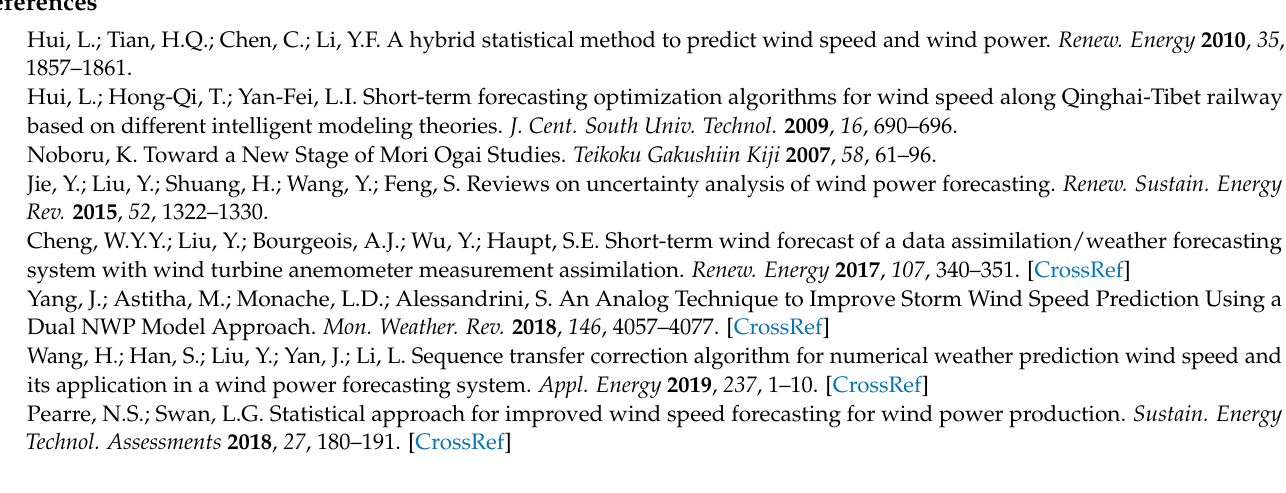
Figure 9. Impact percentage of different wind speed characteristics on indicators.